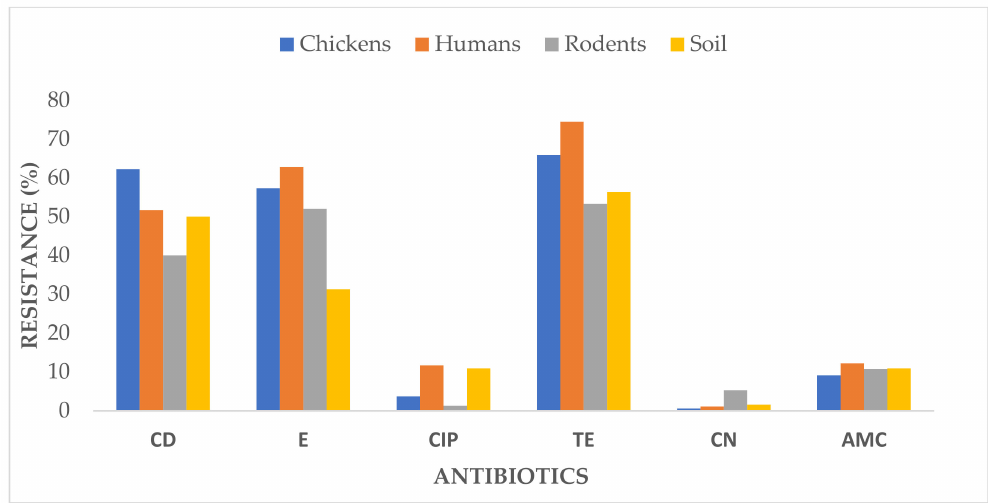
Figure 1. Resistance of S. aureus isolates against the antibiotics; CD = clindamycin, E = erythromycin, CIP = ciprofloxacin, TE = tetracycline, CN = gentamycin, and AMC = amoxicillin-clavulanate. 3.3. Prevalence of Multidrug-Resistant Isolates of S. aureus in Different Types of Samples About 146 out of 483 isolates (30.2%) were resistant to at least three different classes of antibiotics. The population of MDR S. aureus was composed of 70 (14.5%), 51 (10.6%), 15 (3.1%), and 10 (2.1%) isolates from chicken, human, rodent, and soil samples, respectively (Table 3). The MDR rates varied significantly for isolates from chickens, humans, rodents, and soil ( p < 0.001). In all types of samples, none of the MDR S. aureus isolates were resistant to all six classes of